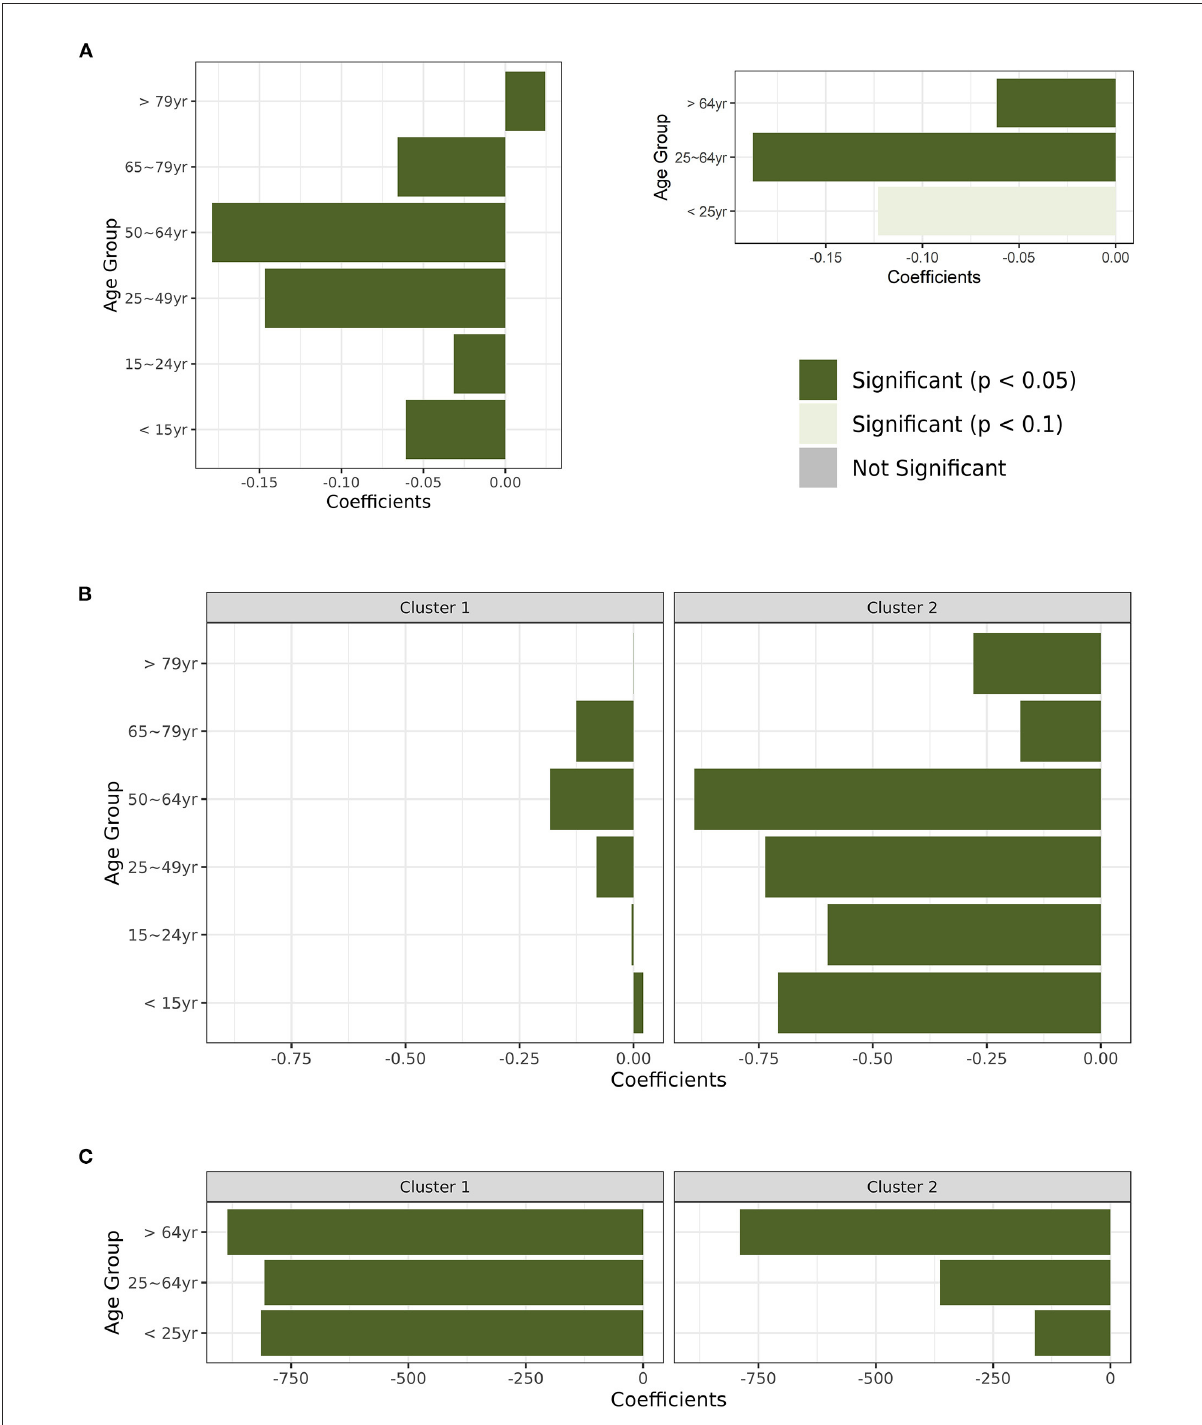
FIGURE4 Results for specific age-group analysis of vaccination on the rate of new COVID-19 cases. (A) All countries with six age-groups and three age-groups. (B) Cluster groups with six age-groups. (C) Cluster groups with three age-groups.